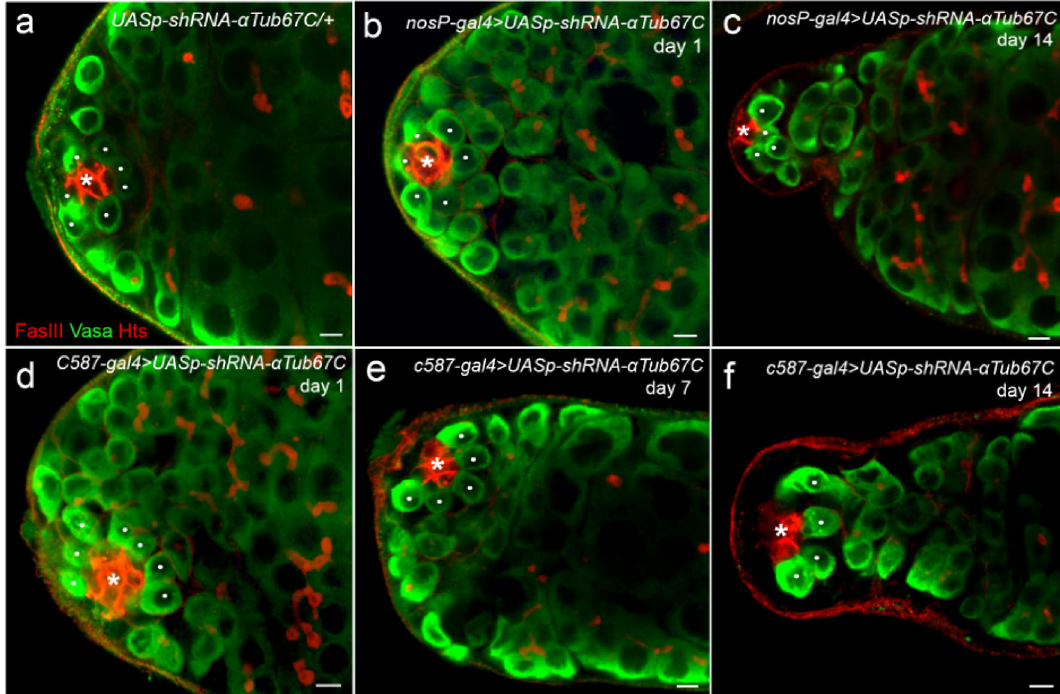
Figure 3. Intrinsic and extrinsic knockdown of αTub67C caused loss of GSCs in Drosophila testis. Testes stained with anti-Fas III antibody (red, indicated by asterisks), anti-Hts antibody (red), and anti-Vasa antibody (green). GSCs were noted by white dots. ( a ) The parental control testis with seven GSCs. The intrinsic αTub67C - knockdown ( nosP-gal4 > UASp-shRNA-αTub67C ) flies ( b , c ) and the extrinsic αTub67C -knockdown ( c587- gal4 > UASp-shRNA-αTub67C ) flies ( d – f ) collected at different days after eclosion. Testes containing 6 GSCs ( b ), 4 GSCs ( c ), 7 GSCs ( d ), 5 GSCs ( e ) and 4 GSCs ( f ). Scale bars: 5